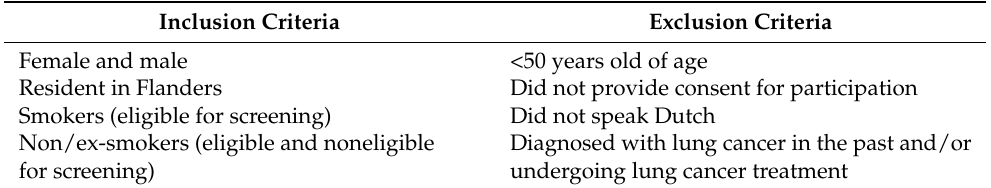
Table 1. Study participant recruitment inclusion and exclusion criteria. This table contains the criteria on the basis of which participants are included or excluded. These criteria were determined following study design and